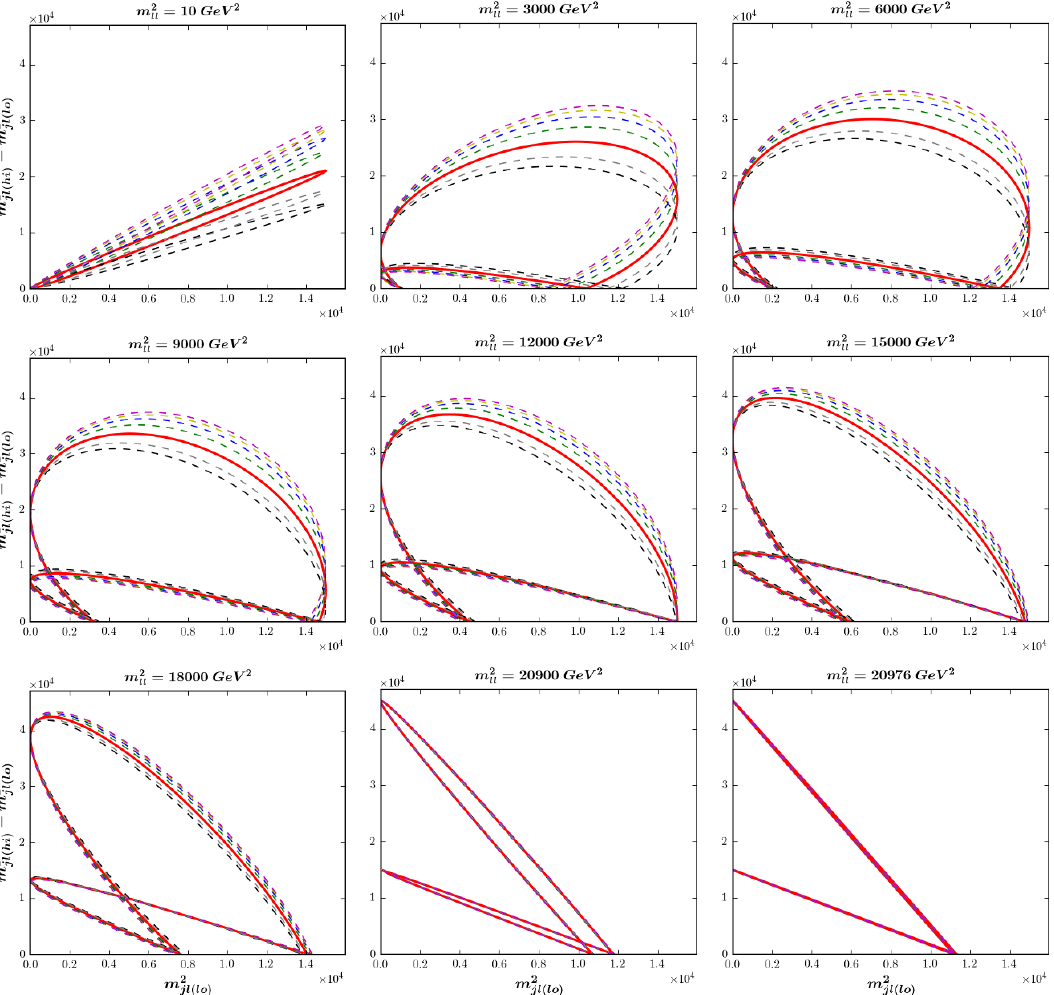
Figure 9 . Signal kinematic boundaries in the ( m 2 of m 2 . Results are shown for several points along the true branch in regions (3 ; 1) and (4 ; 1). The ‘‘ red solid line represents the case of the P 31 study point with ~ m A = 236 : 6 GeV, while the dashed lines correspond to other values of ~ m A along the true branch: ~ m A = 0 (black), ~ m A = 100 GeV (gray), ~ m A = 500 GeV (green), ~ m A = 1000 GeV (blue), ~ m A = 2000 GeV (yellow) and ~ m A = 5000 GeV